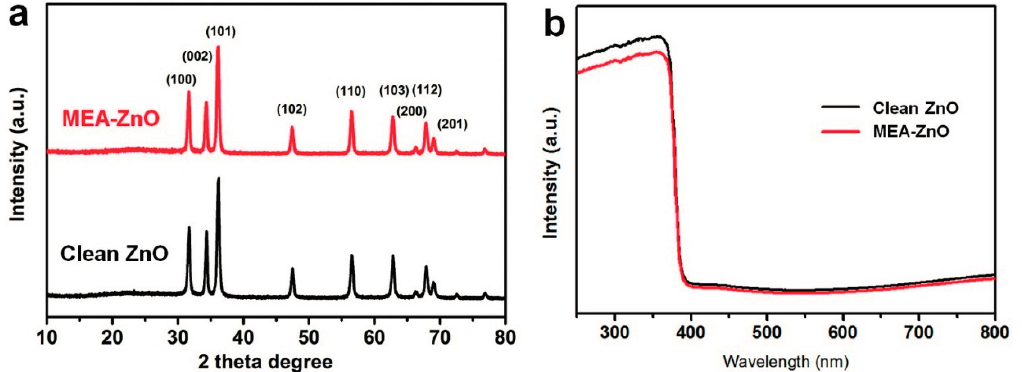
Figure 1. ( a ) XRD patterns of MEA–ZnO and clean ZnO. Both samples can be indexed as wurtzite ZnO; ( b ) UV-Vis spectra of MEA–ZnO and clean